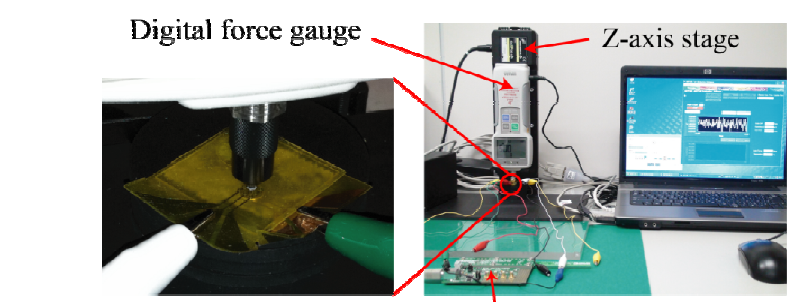
Figure 6. Experimental setup.